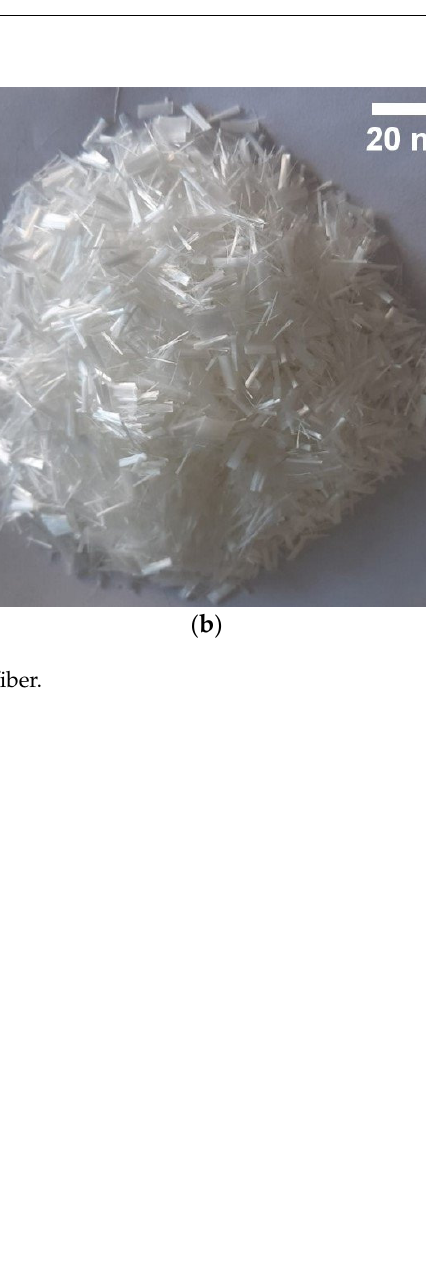
Table 2. Physical properties of binder and filler materials.